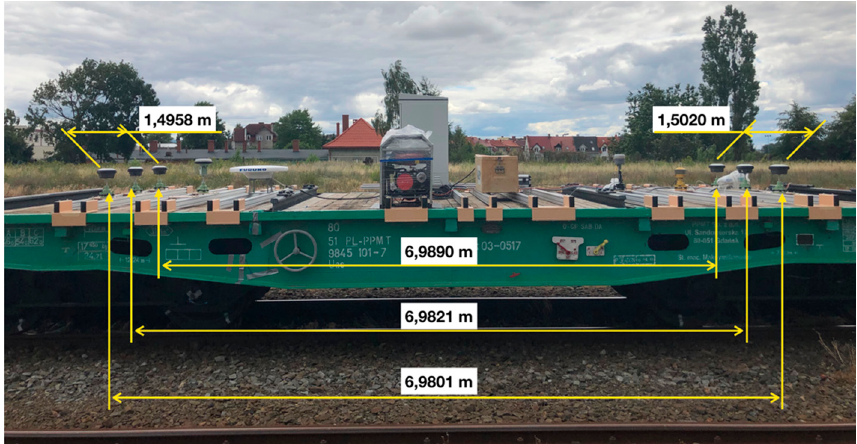
Figure 4. Determined distances between antennas on the surveying platform.